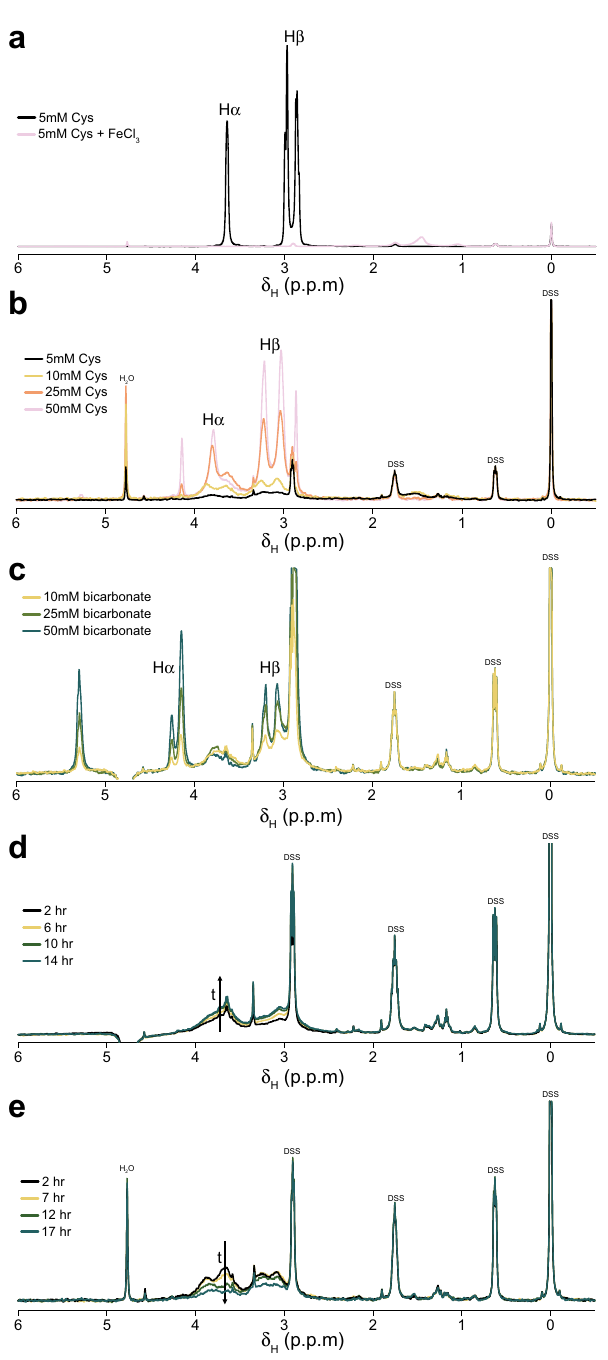
Fig. 7 Cys-FeS clusters continue to form over time under anoxic conditions. 1 H NMR spectra showing a the effect of Fe on free cysteine in solution essentially removing the cysteine signal. b Cys-FeS clusters prepared with increasing cysteine concentrations leading to increased signal for H α and H β of bound cysteine. c HCO 3 − -FeS clusters prepared with increasing NaHCO 3 concentrations leading to increased signal for H α and H β of bound cysteine. d 5 mM Cys-FeS clusters in anoxic conditions over 14 h showing an increase in cysteine incorporation, and e 5 mM Cys- FeS clusters in the presence of oxygen over 14 h showing a decrease in bound cysteine. All solutions were prepared at pH 9. Source data are provided as a Source data fi